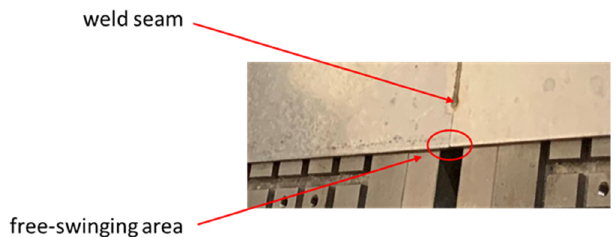
Figure 2. Detailed view of the joining edge and free ‐ swinging